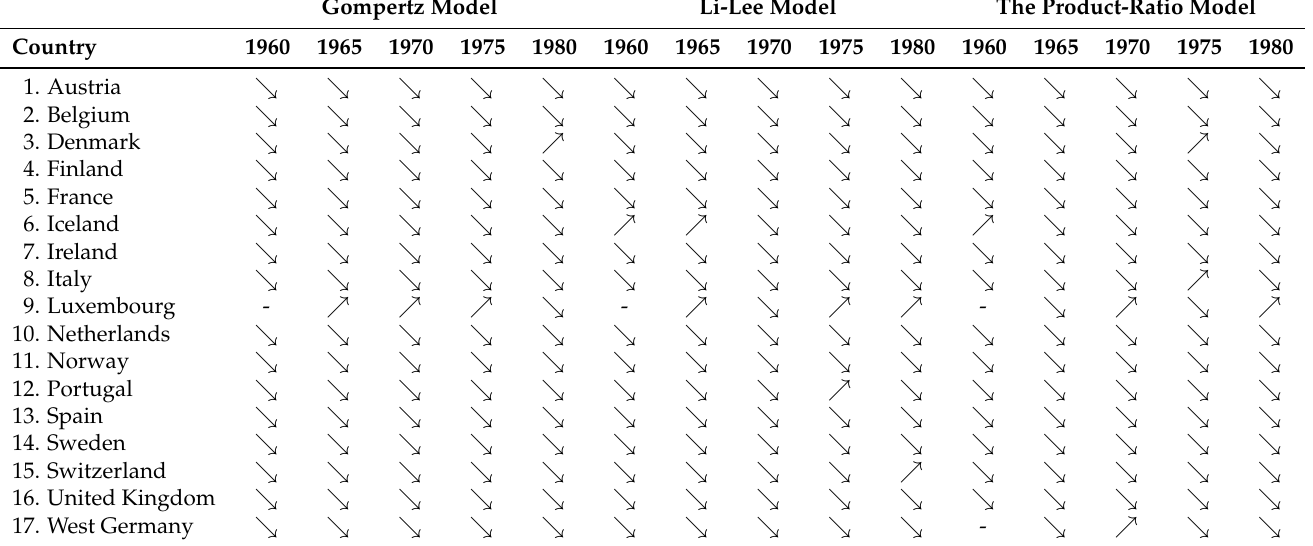
Table 2. Direction of the sex gap five years after projection jump-off for different coherent models and jump-off years. The table shows whether the gap is narrowing ( (cid:38) ) or widening ( (cid:37) ). The models are calibrated to data in the period 1950 (or the earliest year where data are available) to the listed jump-off year. No direction is shown if the model cannot be calibrated (i.e., lack of